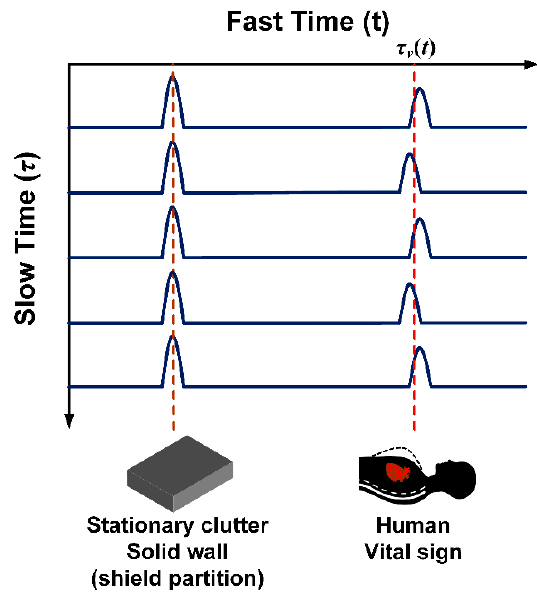
Figure 7. Reflected signals from human and solid object in fast time and slow time.